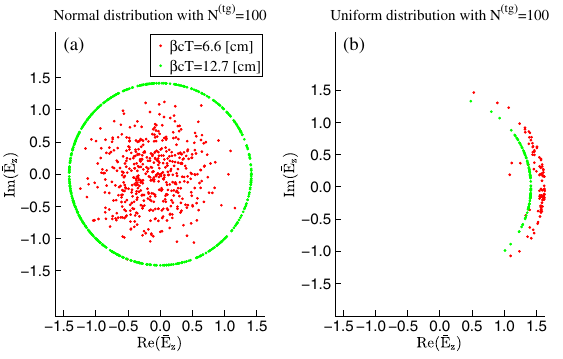
FIG. 4. The same as Fig. 3 but with N ð tg Þ ¼ 100 .